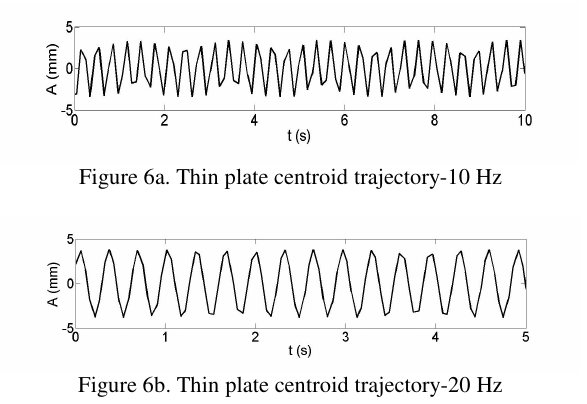
Figure 6b. Thin plate centroid trajectory-20 Hz